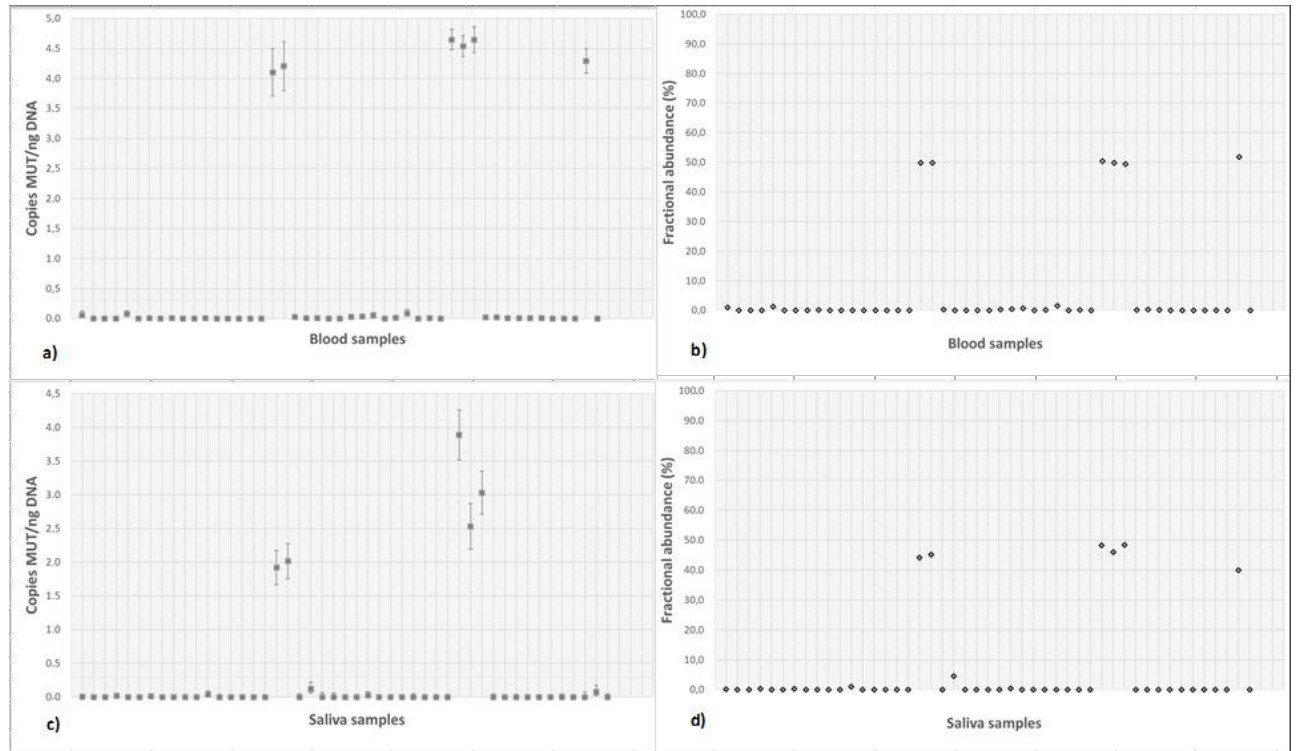
Figure 1. Numbers of copies of the mutated allele detected in blood ( a ) and saliva ( c ) samples using ddPCR, as well as fractional abundance calculated from blood ( b ) and saliva ( d ) samples. Parameters showing the performance of the ddPCR-based analysis of saliva isolates for prediction of blood-based results (considered true values) evaluated by a combined method of the determination of the number of copies and fractional abundance are pre- sented in Table 2. Table 2. Basic test parameters for saliva-based ddPCR detection of FV mutation using both the sim- ple number of copies (left) and fractional abundance (right); 95% confidence intervals are shown in the brackets . Please note that results from blood samples were used as reference (100%) and absolute numbers were identical to those described for evaluation using fractional abundance.